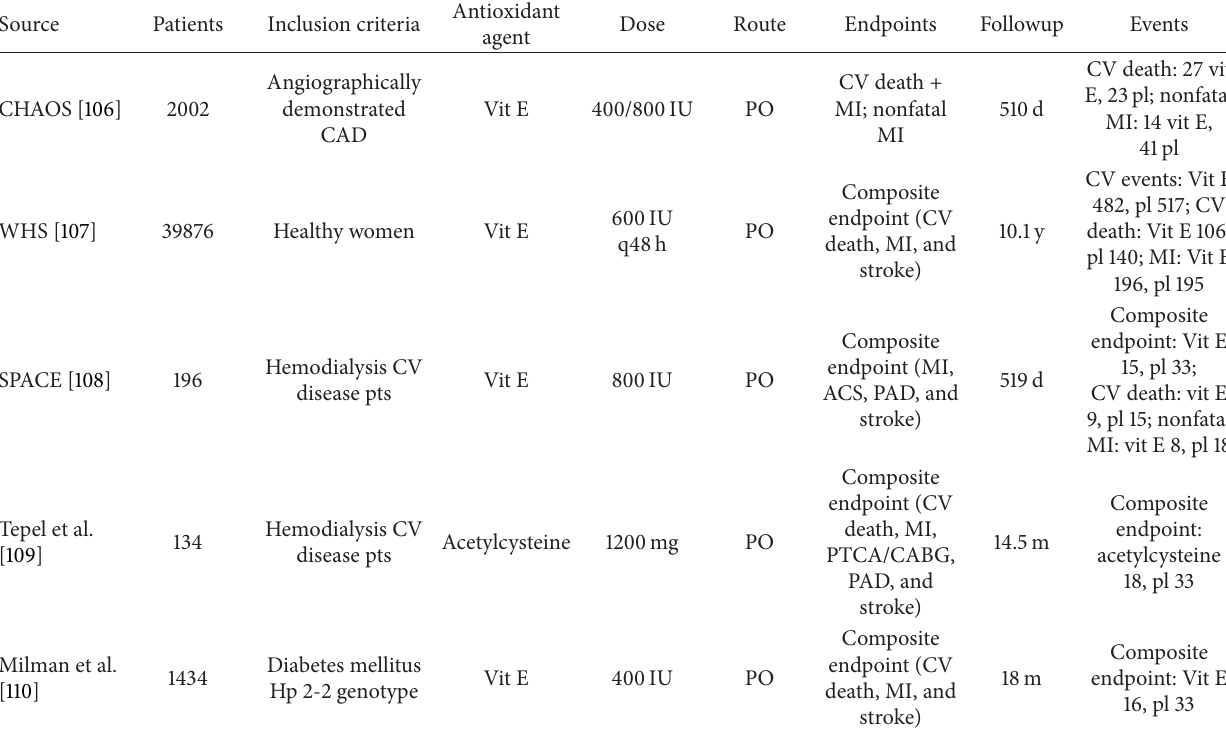
Table 3: Randomized controlled trials demonstrating a beneficial effect of antioxidant